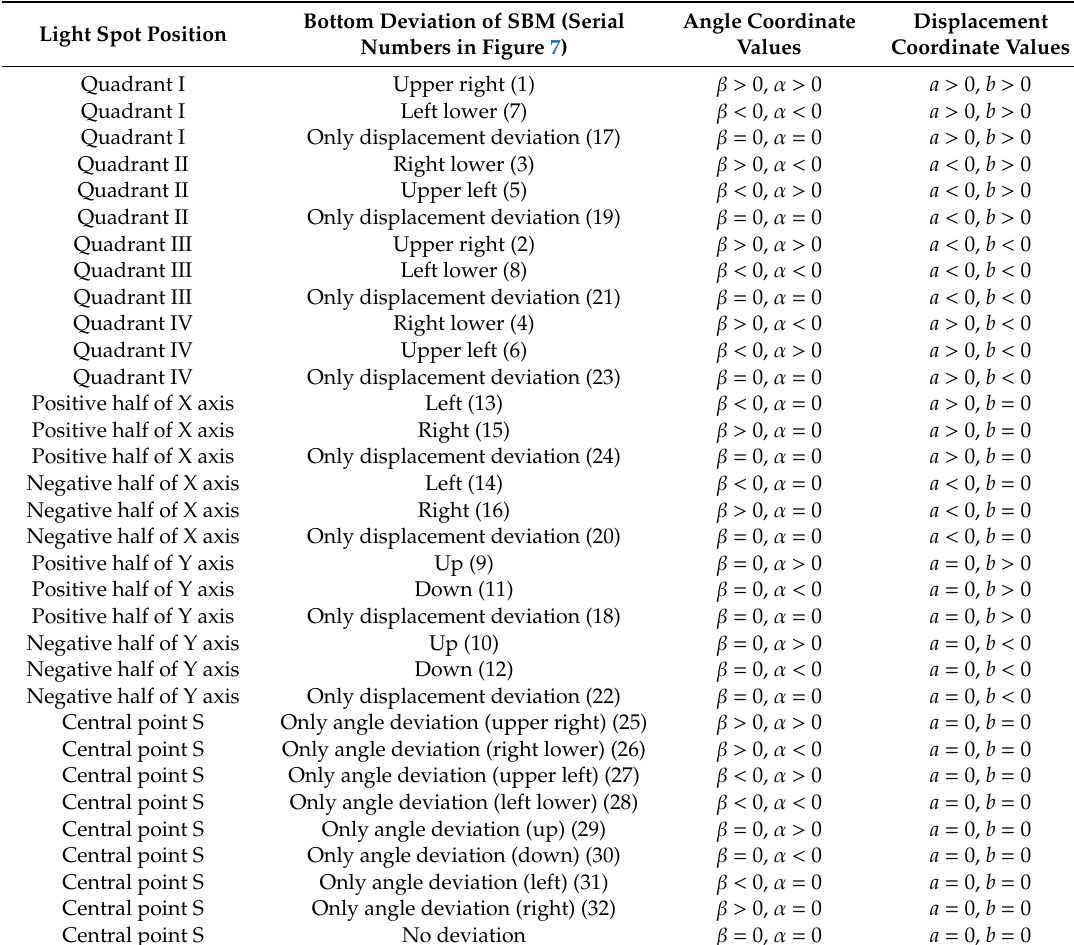
Table 1. Relationship between the attitude changes and coordinate values.